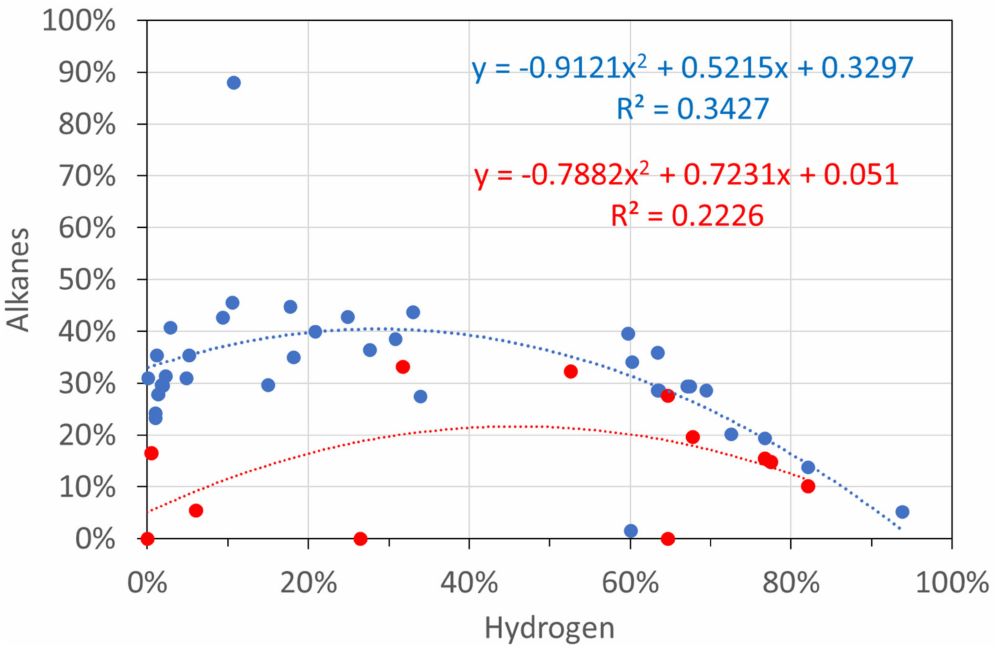
Figure A5. Molar gas analyses: hydrogen vs. alkanes. Blue circles: T ≤ 298 K; red circles: T = 348 K.